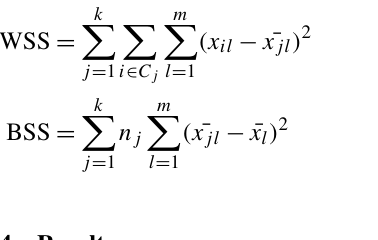
sum of squared deviations within classes (WSS, Fig.